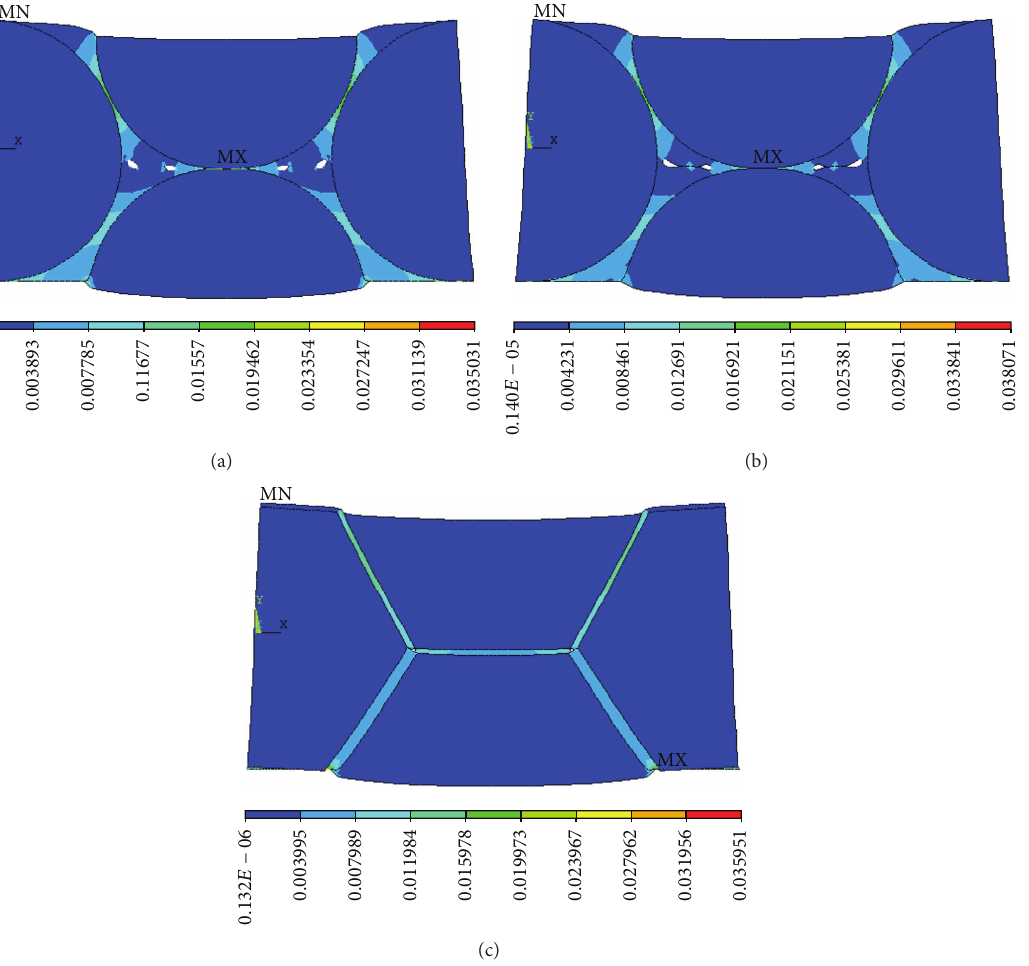
Figure 13: Total mechanical strain intensity for three models: (a) circular pores; (b) circular pores with acute angle; (c) hexagon pores with acute